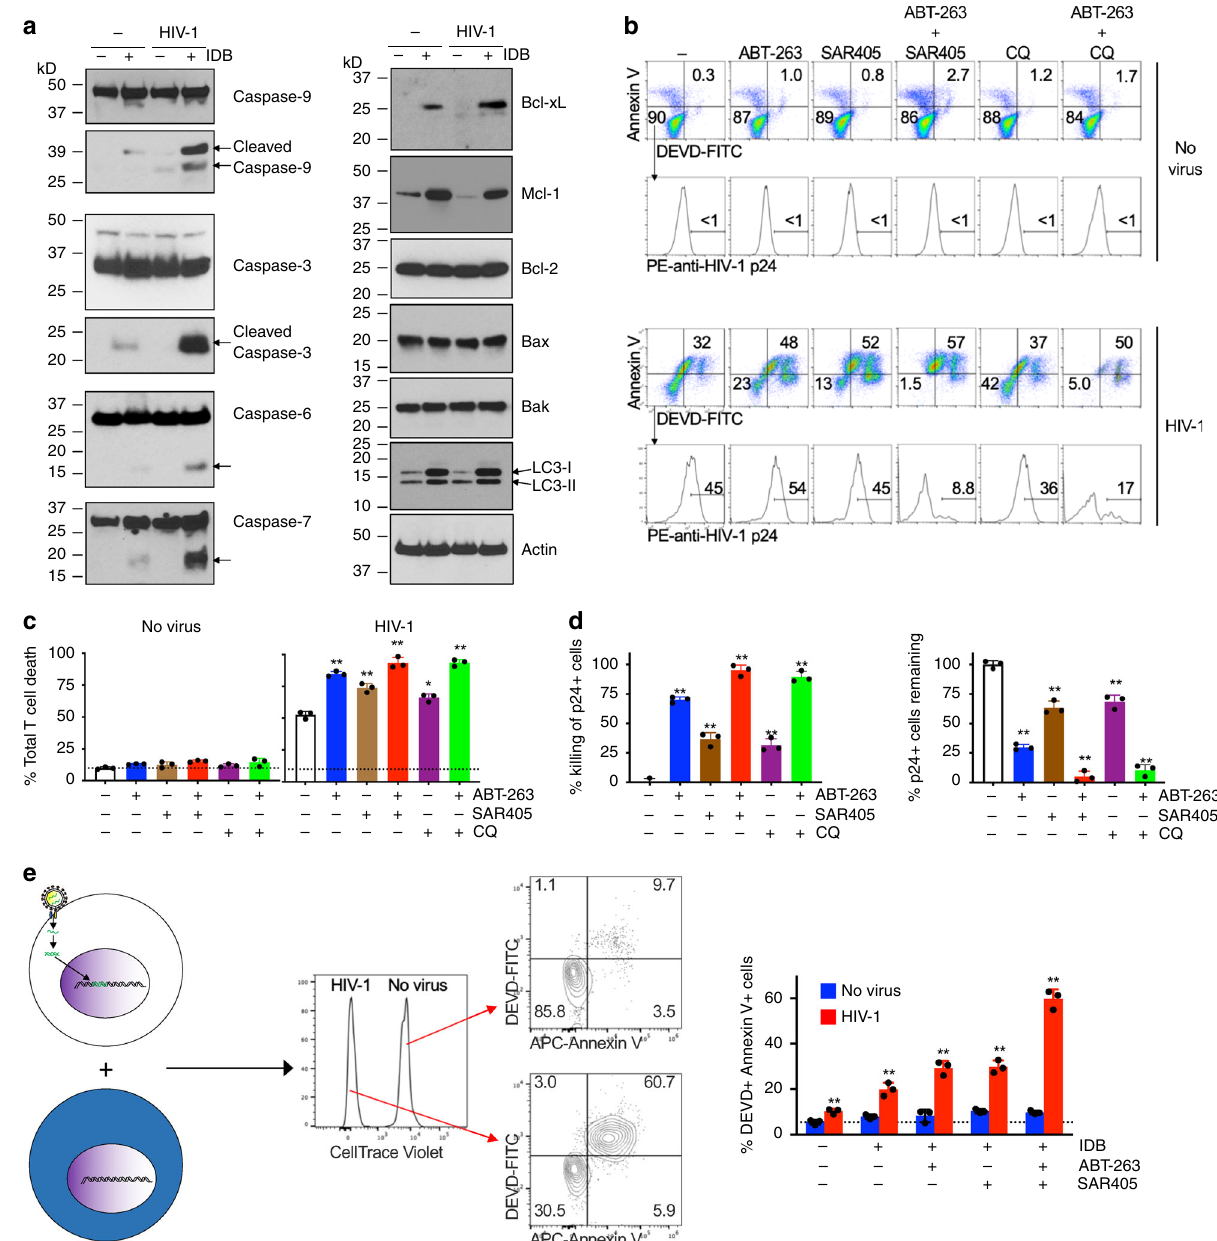
Fig. 2 Induction of caspase activation and cell death in HIV-1-infected T cells. a CD4 + T cells from PBMCs with or without infection by HIV-1 (NL4-3, 1 MOI) were cultured for 4 days to establish latency, followed by stimulation with IDB for 24 h. Cell lysates were used for western blot (representative of two biologically independent experiments). Arrows indicate cleaved caspases. b CMT with or without infection by HIV-1 (NL4-3, 1 MOI) were cultured